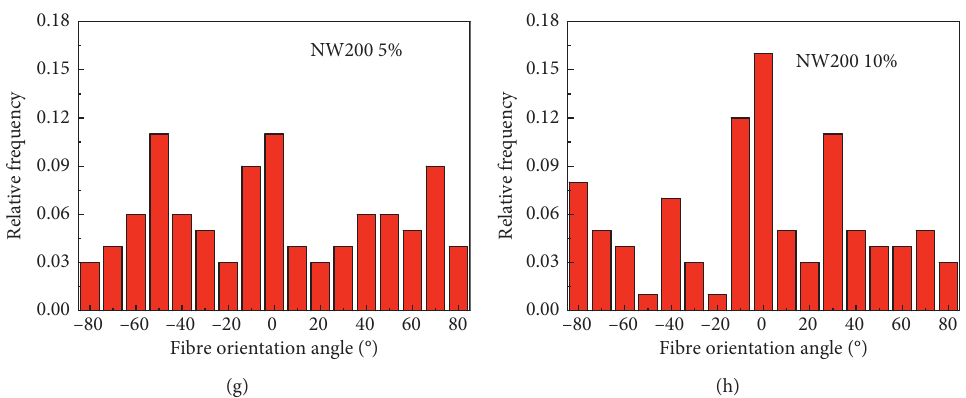
Figure 5: Histograms of relative frequency of fibres subjected to different uniaxial tensile strain. (a) NW100 0%. (b) NW100 3%. (c) NW100 5%. (d) NW100 10%. (e) NW200 0%. (f) NW200 3%. (g) NW200 5%. (h) NW200 10%. Table 2: Directional parameter K α at different levels of strains. Strain (%)